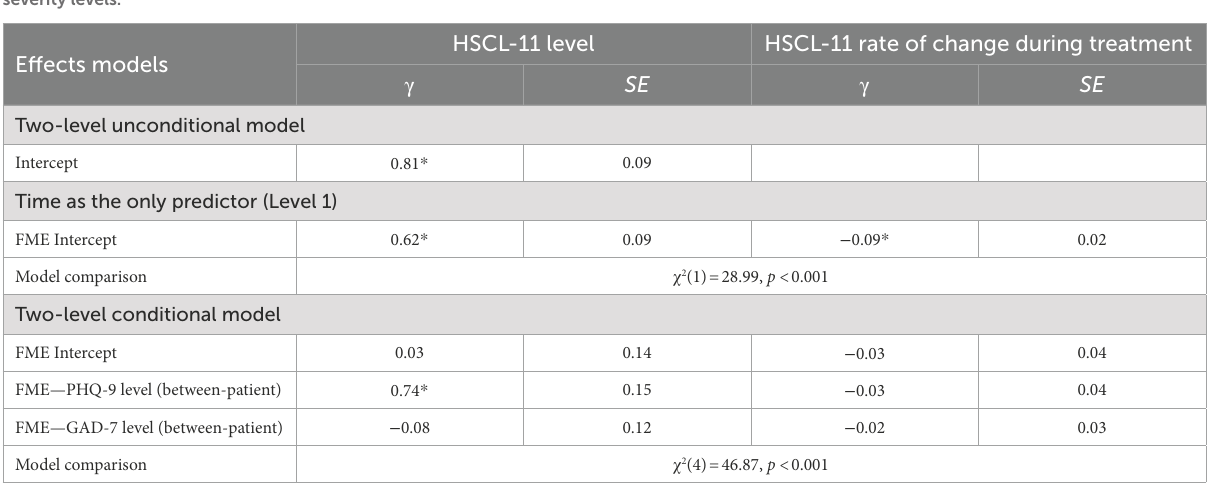
TABLE 4 Results from the unconditional model, the model with time as the only predictor and the model of the effect of depression and anxiety on severity